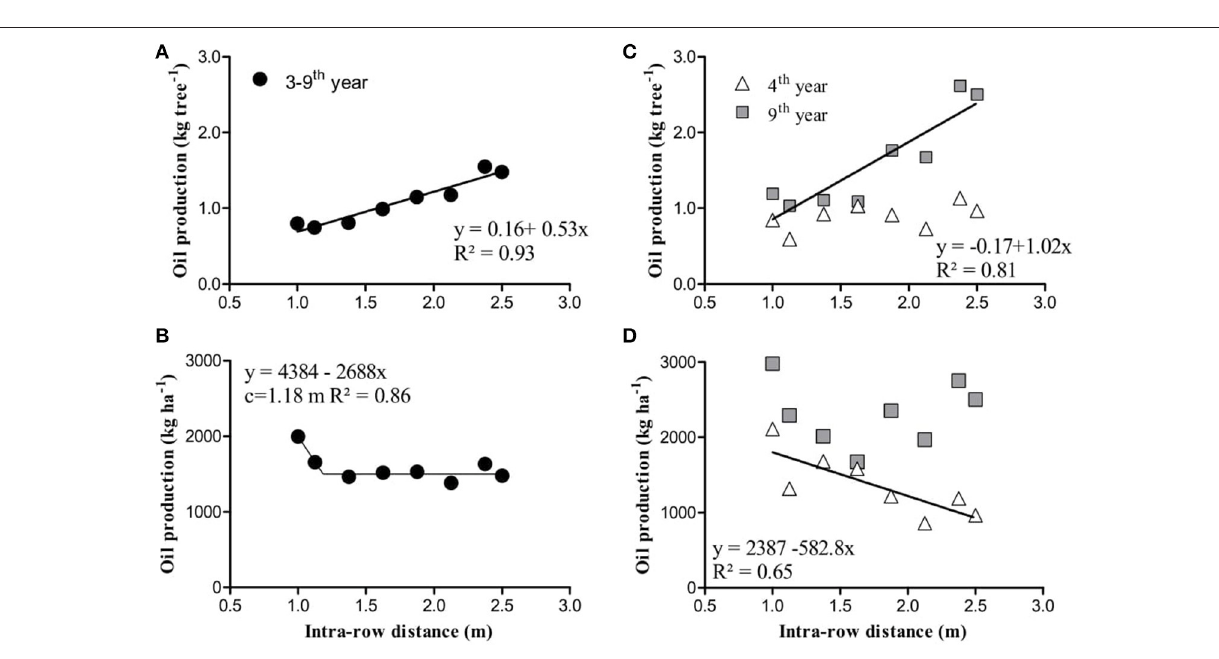
achieve continuous hedgerows suitable for over-row harvesters because strong branches entering the intra-row space were